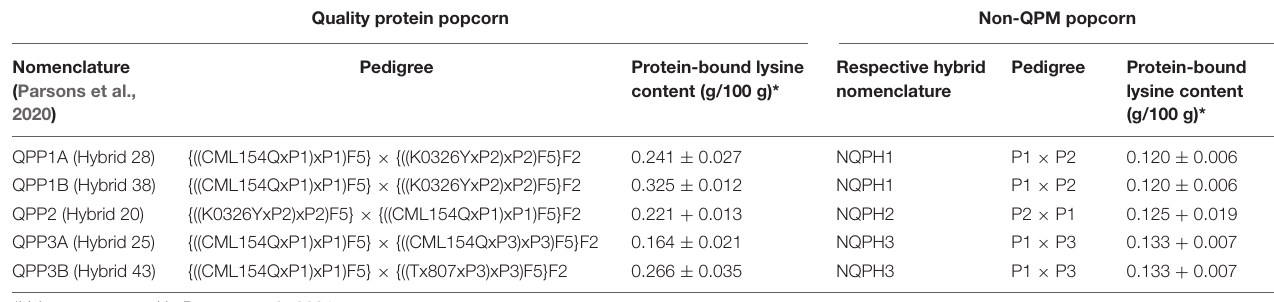
TABLE 1 | Description of the pedigree of non-quality-protein parental hybrid (NQPH) lines and quality-protein popcorn (QPP) derivatives. Quality protein popcorn